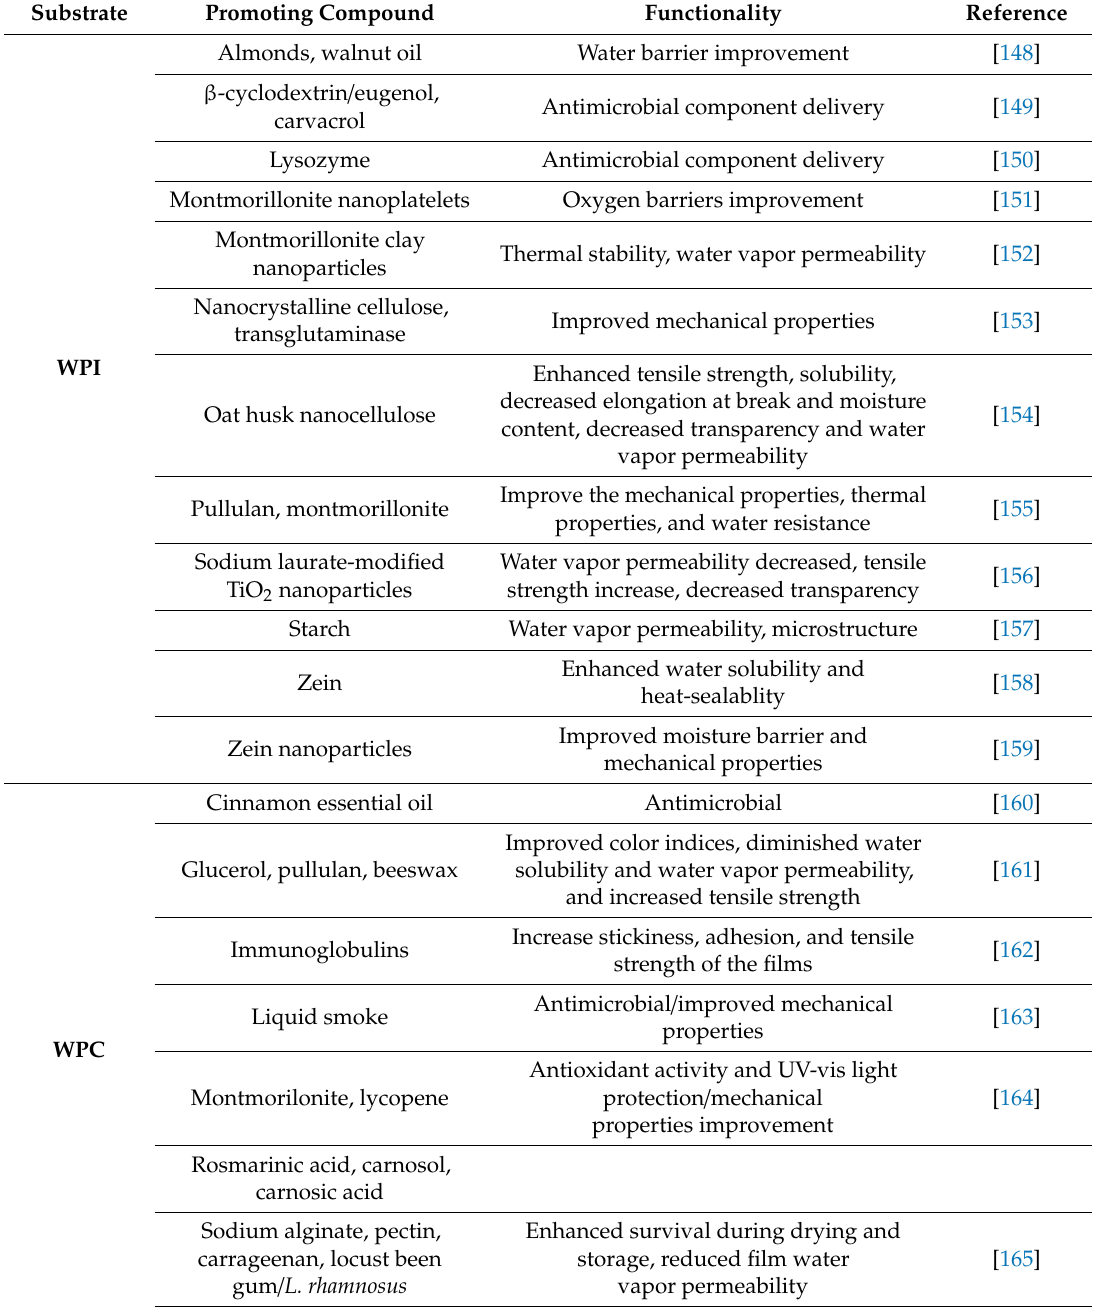
Table 3. Edible films formation from whey protein isolate (WPI) and whey protein concentrate (WPC) and their functional